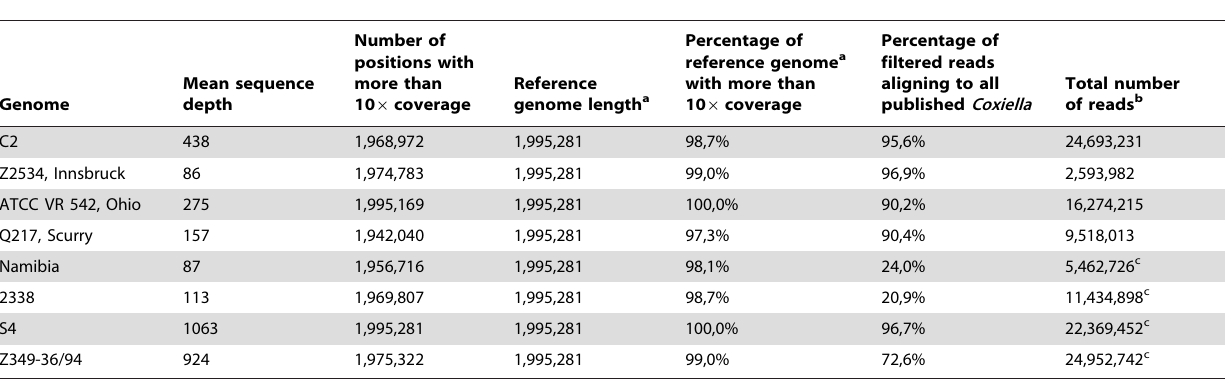
Table 2. Genome sequence data statistics of the eight new Coxiella burnetti strains sequenced in this study.